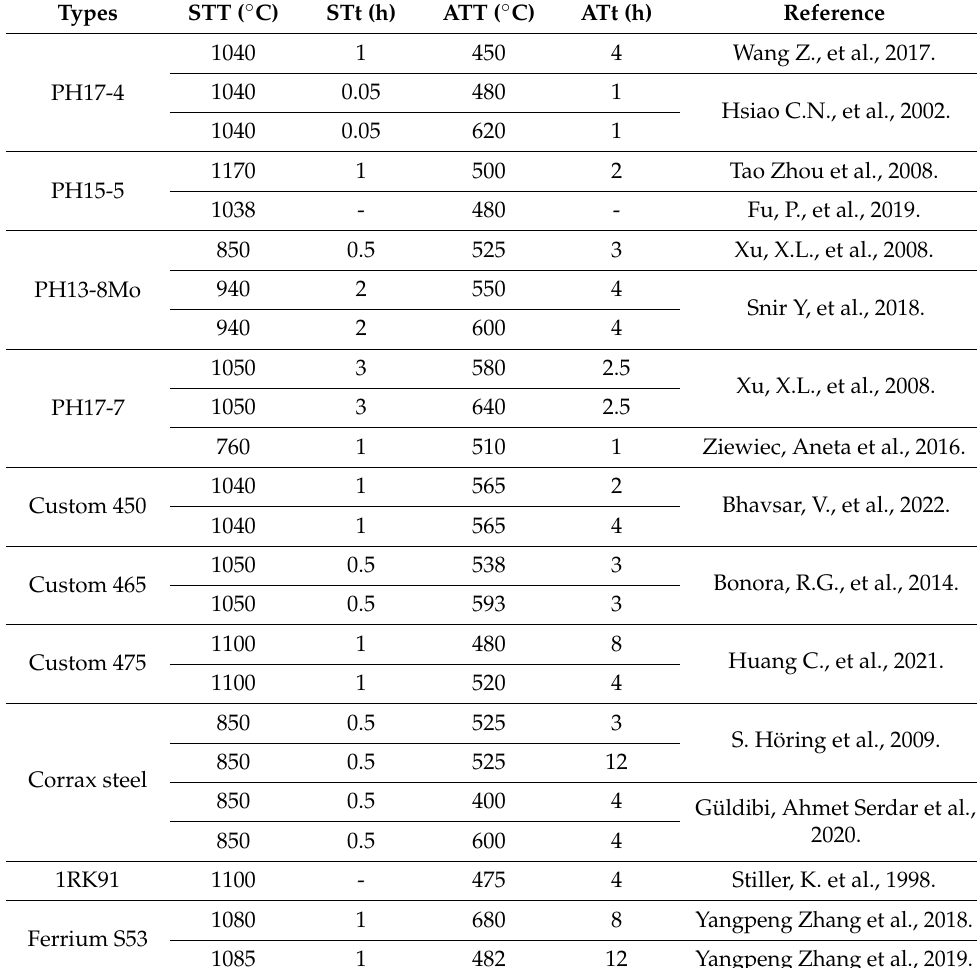
Table 3. Classical heat treatment regime of PHSS